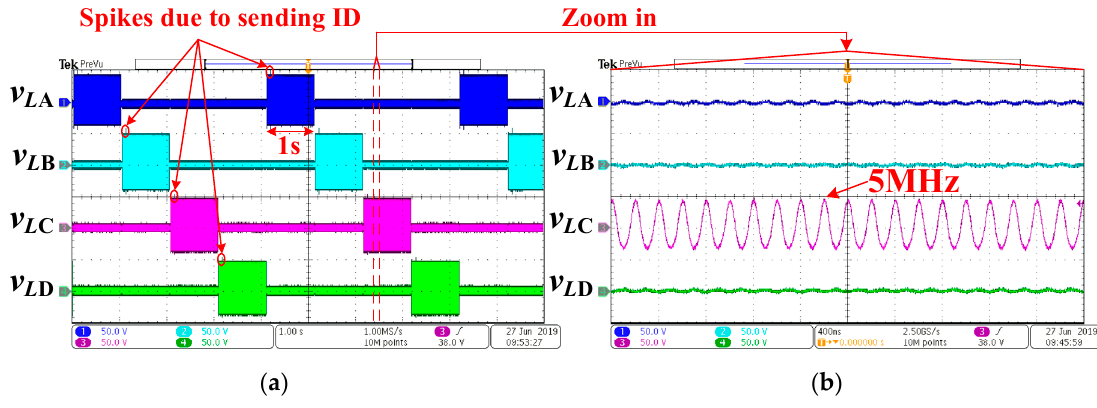
Figure 13. ( a ) Transmitting waveforms of auxiliary signal coils; ( b ) zoom-in waveforms when L C is enabled.